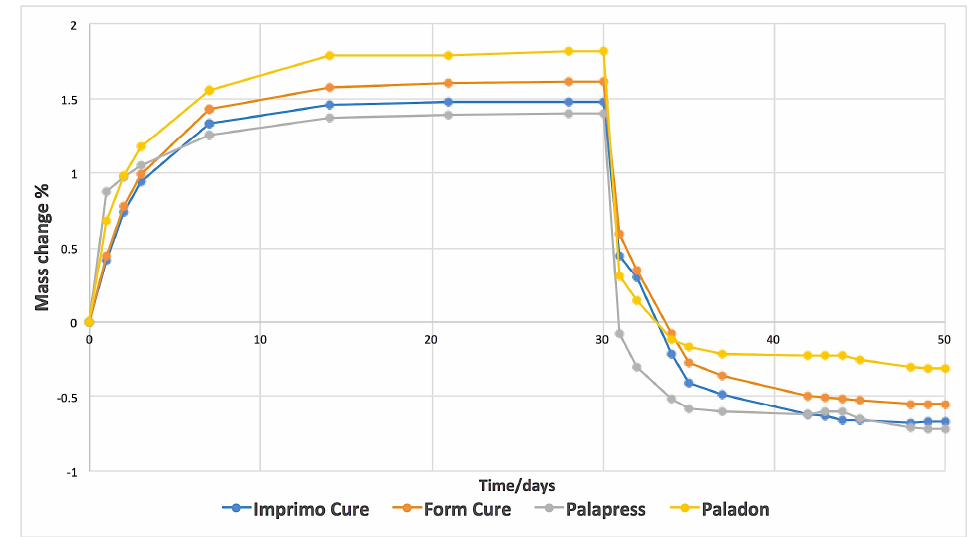
Figure 3. A representative plot of mass change % against time for tested groups/subgroups during water immersion and